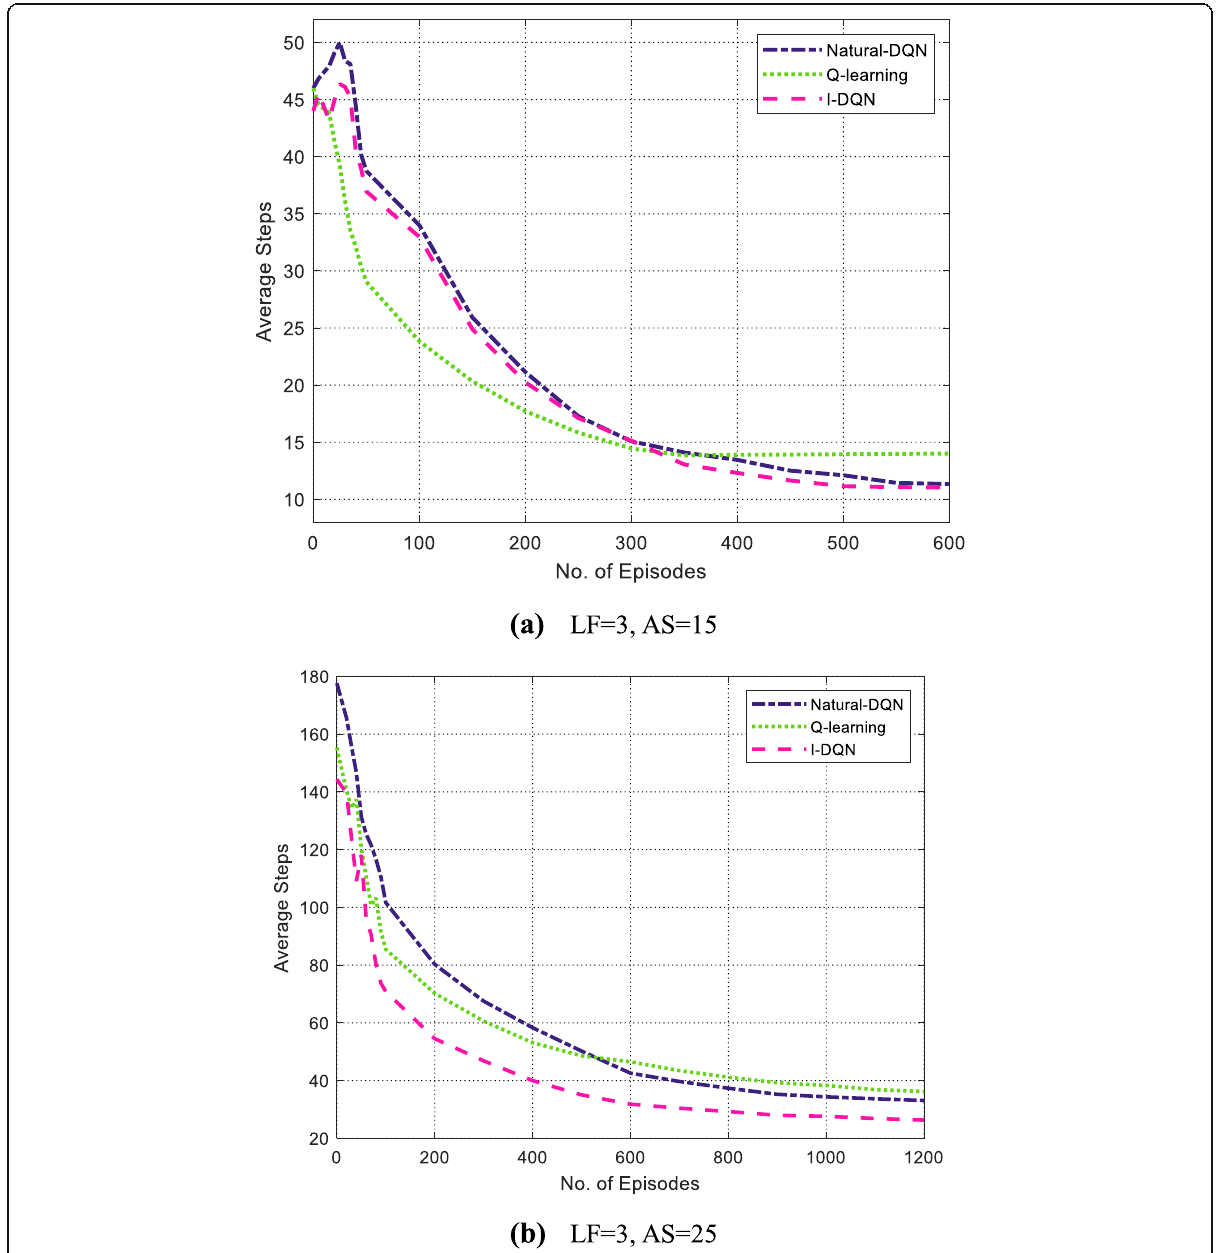
Fig. 8 Average steps variation vs. no. of episodes in different scenarios. This figure depicts the convergence performance comparison for three approaches, I-DQN, Q-learning, and Natural-DQN, in the situations of LF = 3, AS = 15, and LF = 3, AS =